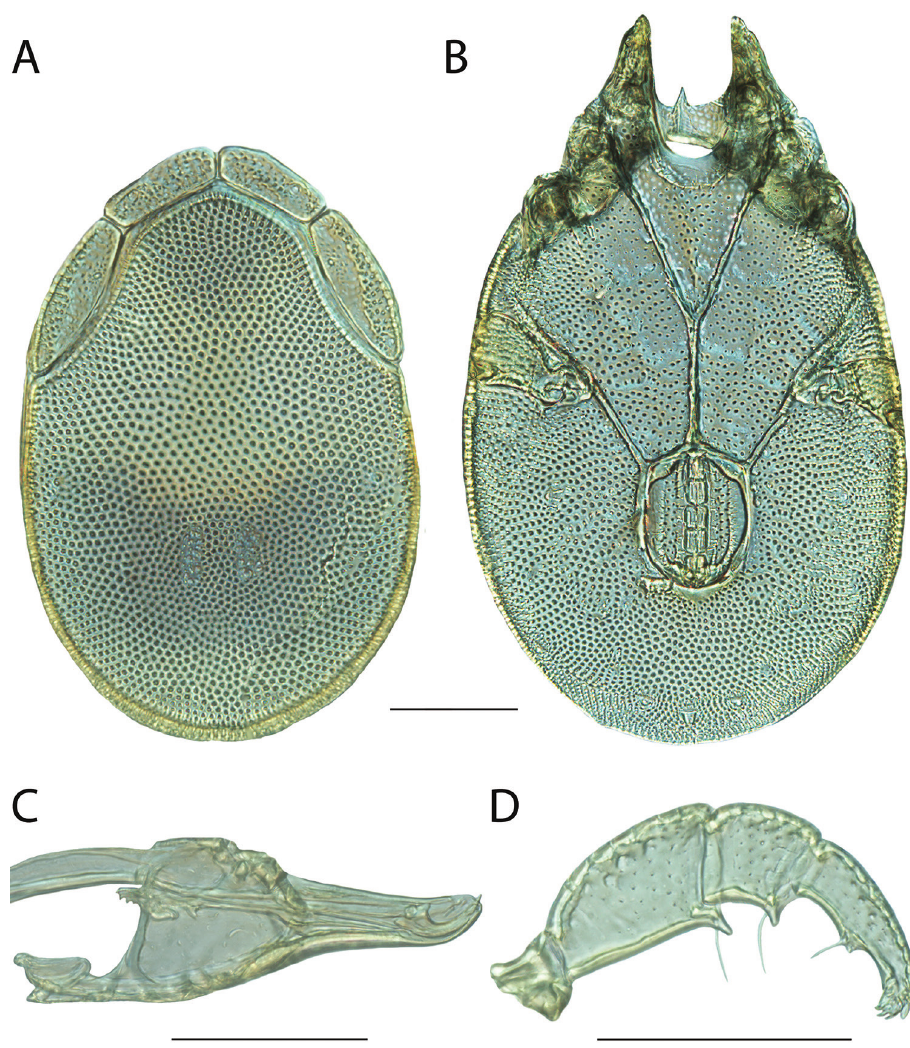
Figure 239. Torrenticola shubini sp. n. male: A dorsal plates B venter (legs removed) C subcapitulum D pedipalp (setae not accurately depicted). Scale = 100